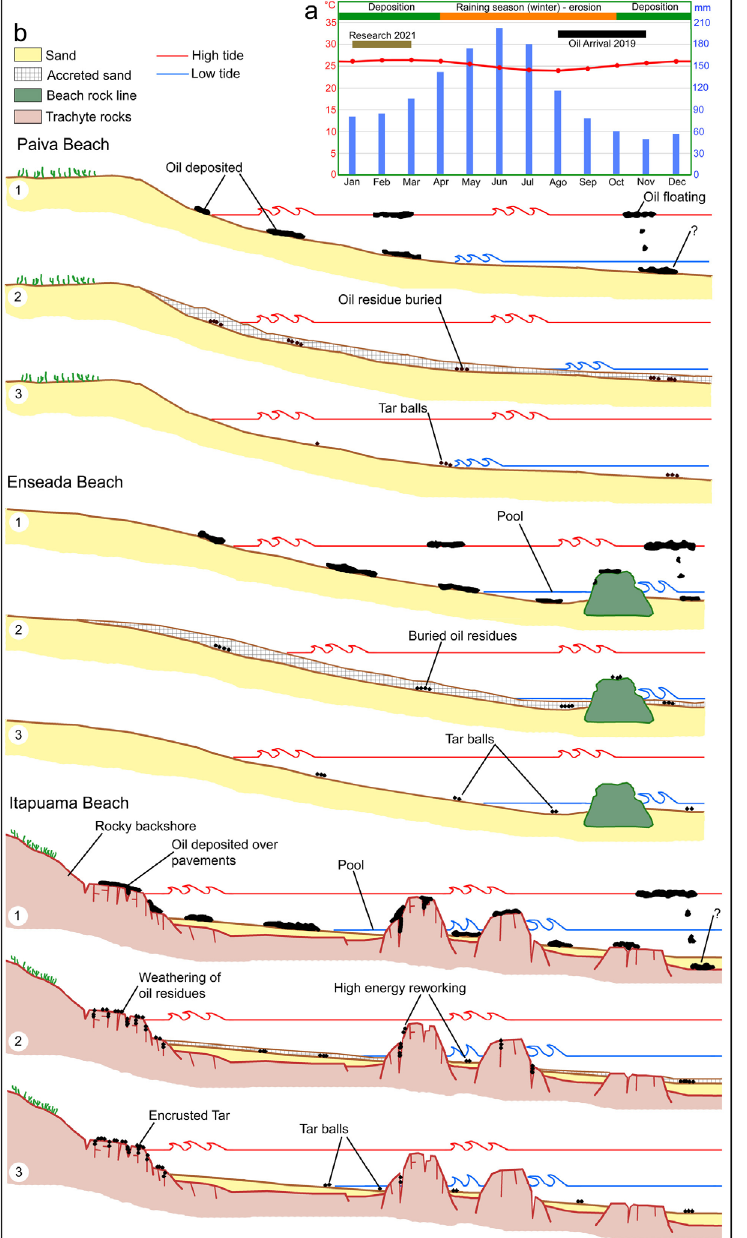
Figure 10. Schematic model of oil contamination evolution. a) Climograph with monthly average temperatures (red) and precipitation (blue) for Cabo de Santo Agostinho City (source: climatedata.org/Copernicus Climate change Services. Weather data were collected between 1999-2019). The rainy season (winter) marks the period of seasonal erosion. b) The proposed three stages for the evolution of oil residues in the studied beaches. 1 - Deposition of oil. The tidal variation allowed the contaminants to reach the foreshore and parts of the backshore zone. This stage occurred after the erosive period when the sandy beaches presented a concave profile. 2 - Residues left after the cleaning operation were reworked and buried due to the high-energy process of sand remobilization. During this period, oil residues underwent intense weathering (chemical, mechanical, biochemical) and breakdown. 3 - The following erosive stage allowed the exhumation of sand- oil aggregates (beached tar balls). The weathering of the oil residues encrusted in the rocky shore underwent a different evolution, which prevented its